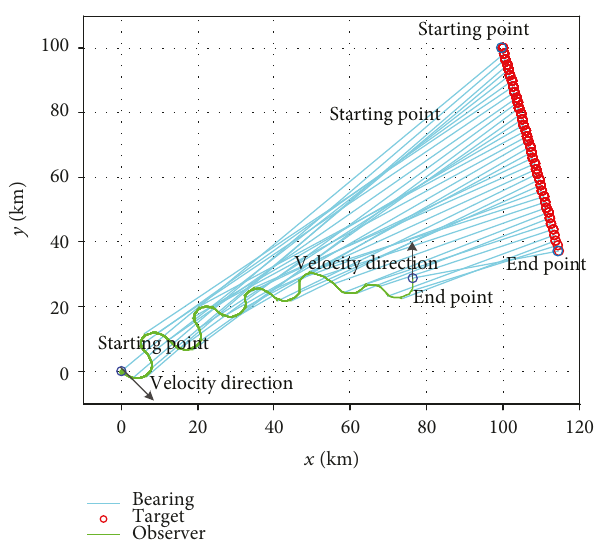
Figure 7: Target tracking results in scenario 3,